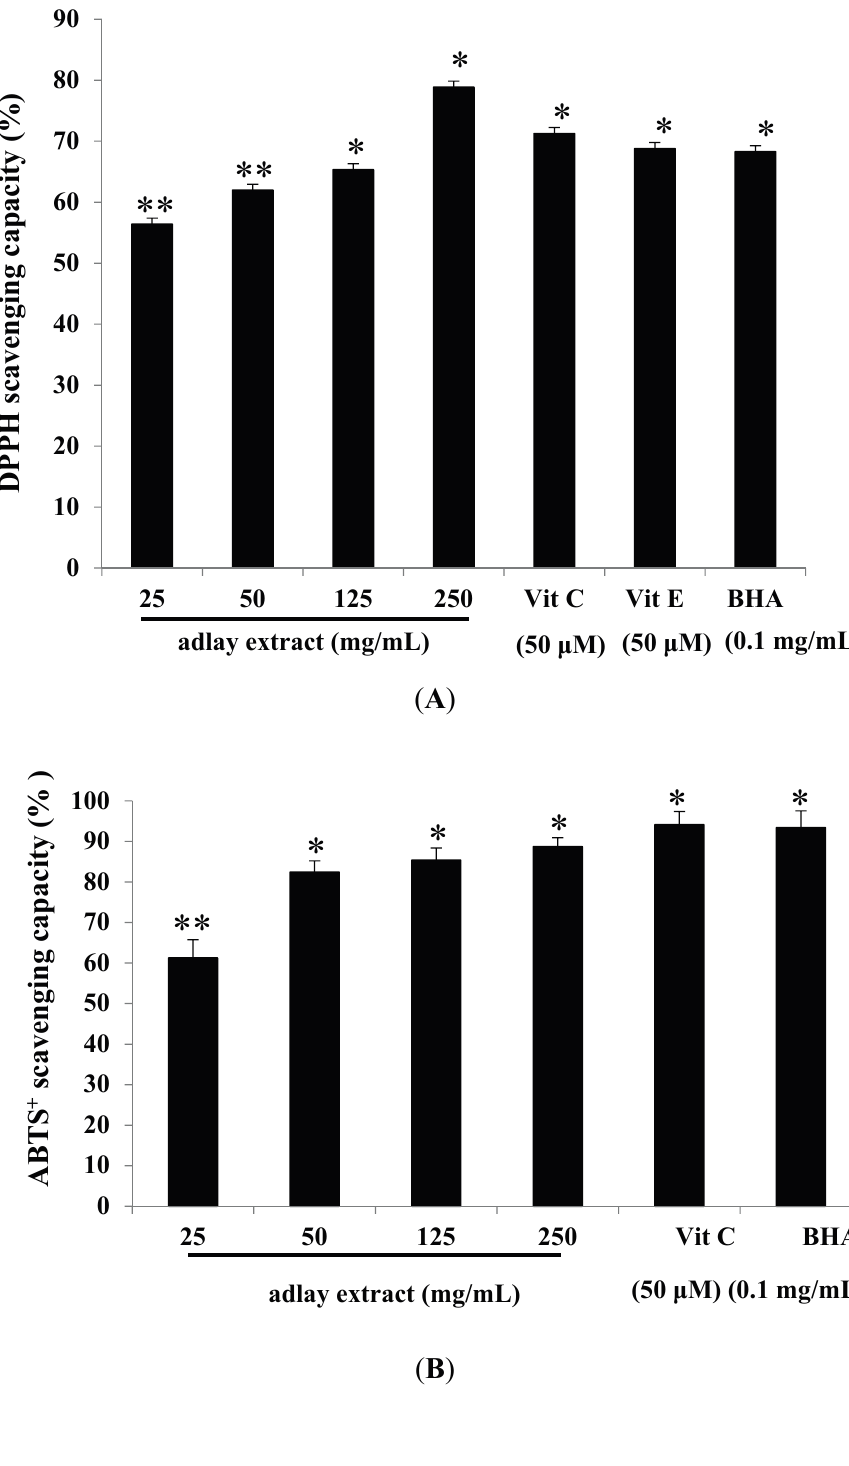
Figure 3. The antioxidant characteristics of adlay extract. ( A ) DPPH scavenging capacity assay; ( B ) ABTS + radical scavenging activity assay; ( C ) Determination of reducing capacity; ( D ) Measurement of total phenolic content; ( E ) ROS level assay. Different concentrations of the adlay extract and positive standards were used in the above assays. The results are expressed as percentages of the control. The data are presented as the mean ± S.D. * p < 0.05, ** p <